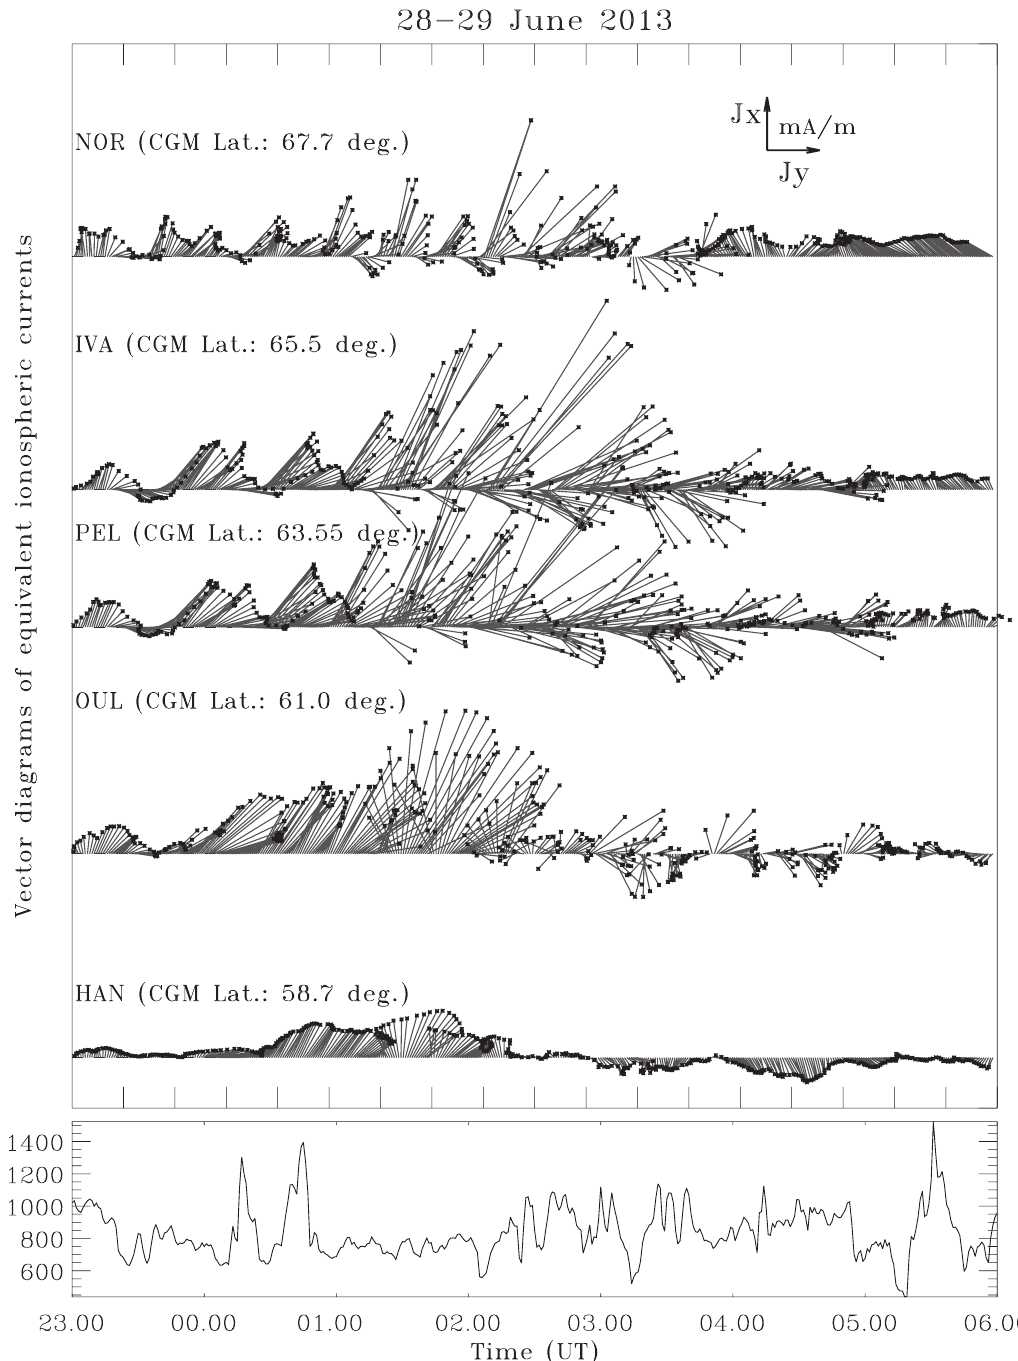
Fig. 14. Vector diagrams of 1-min equivalent ionospheric current J corresponding to Pi3 pulsations for the period from 23 UT on June 28 to 06 UT on June 29, with time cadence 1